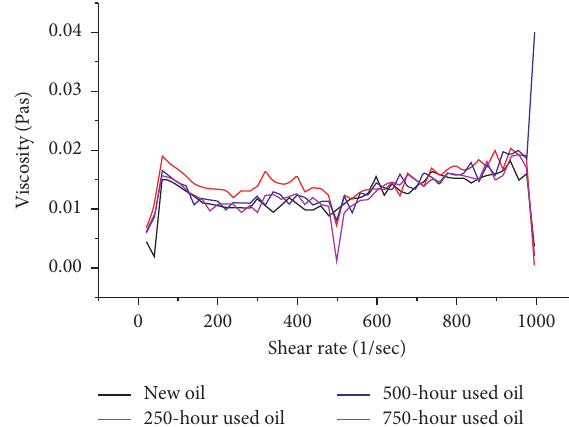
Figure 17: A combined graph of change in viscosity with shear rate at 80 °